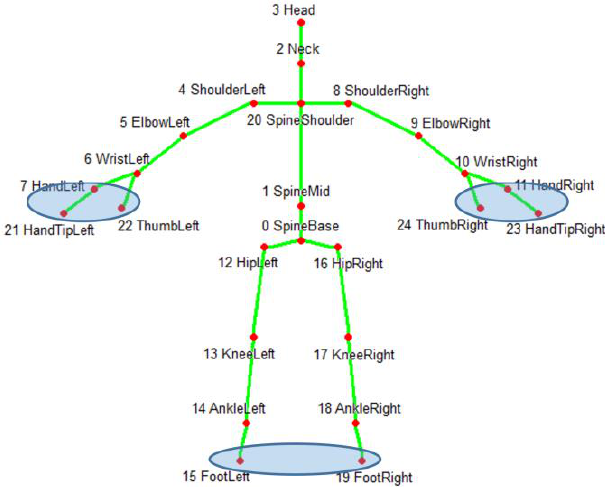
Figure 4. Skeleton provided by Microsoft Kinect v2 and points excluded from analysis (grey ovals)